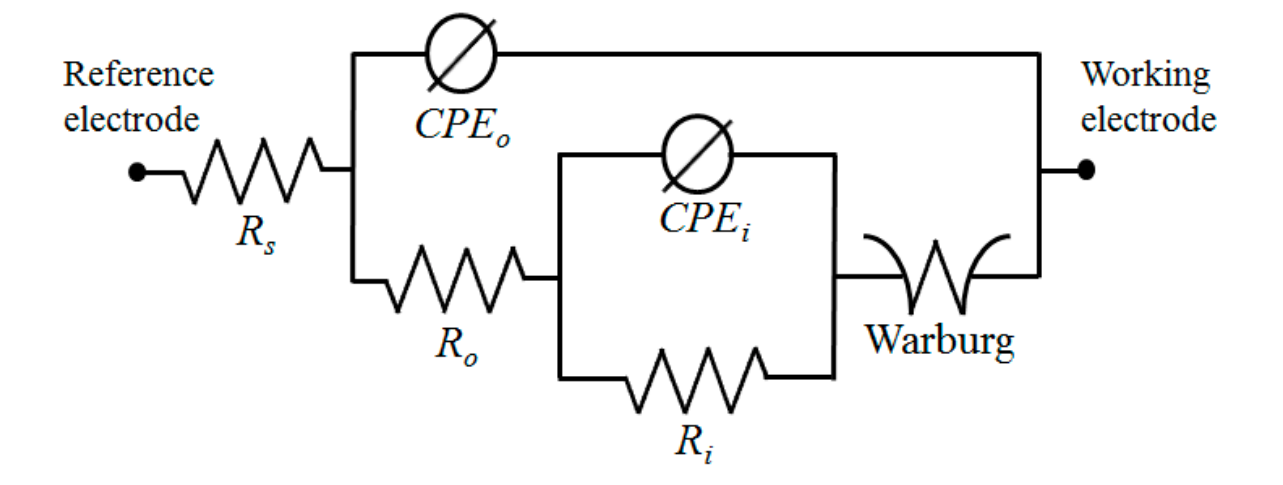
Figure 6. The equivalent circuit model used for fitting Nyquist